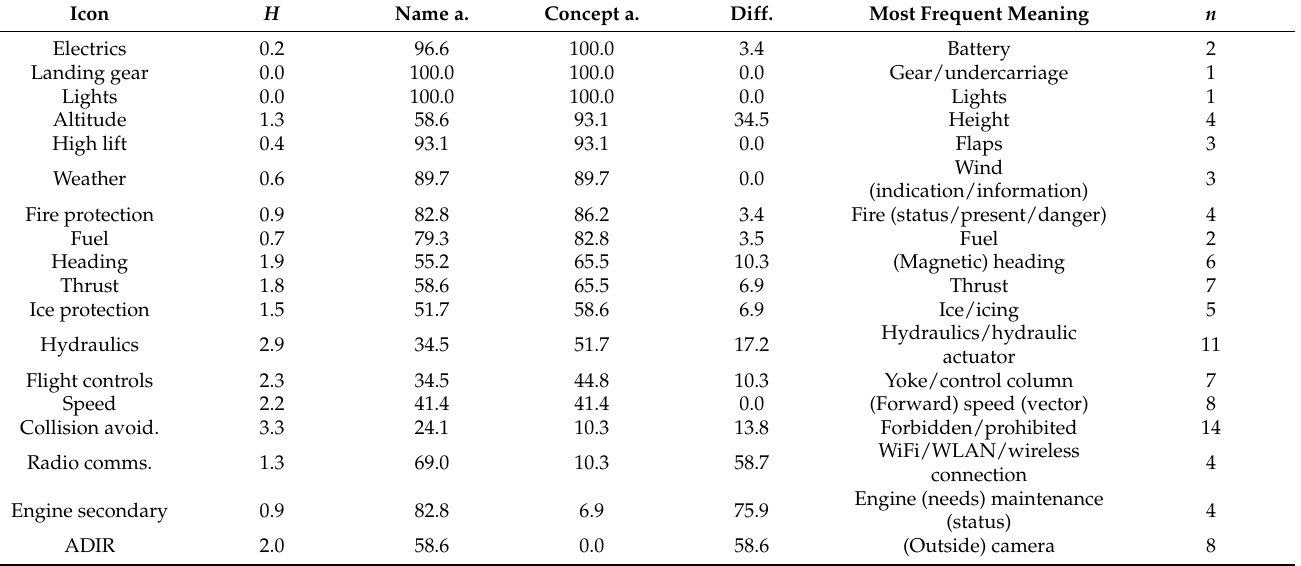
Table 6. Results for H , name agreement (Name a.) and concept agreement (Concept a.) (%), the difference between concept and name agreement scores (Diff.), the most frequently given meaning and the number of different meanings given for each icon ( n ). The icons are ranked in descending order by the score for concept